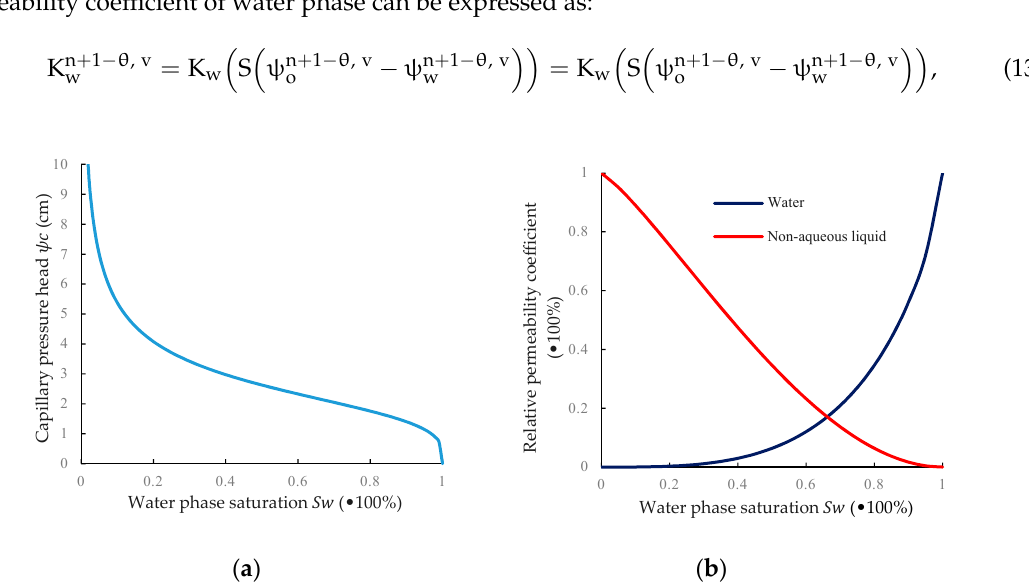
Figure 3. Nonlinear character of water and NAPL two-phase flow: ( a ) Two-phase flow characteristic curve of the water-non-aqueous liquid; and ( b ) the relative permeability coefficient of each phase depends on the change of the water phase saturation.